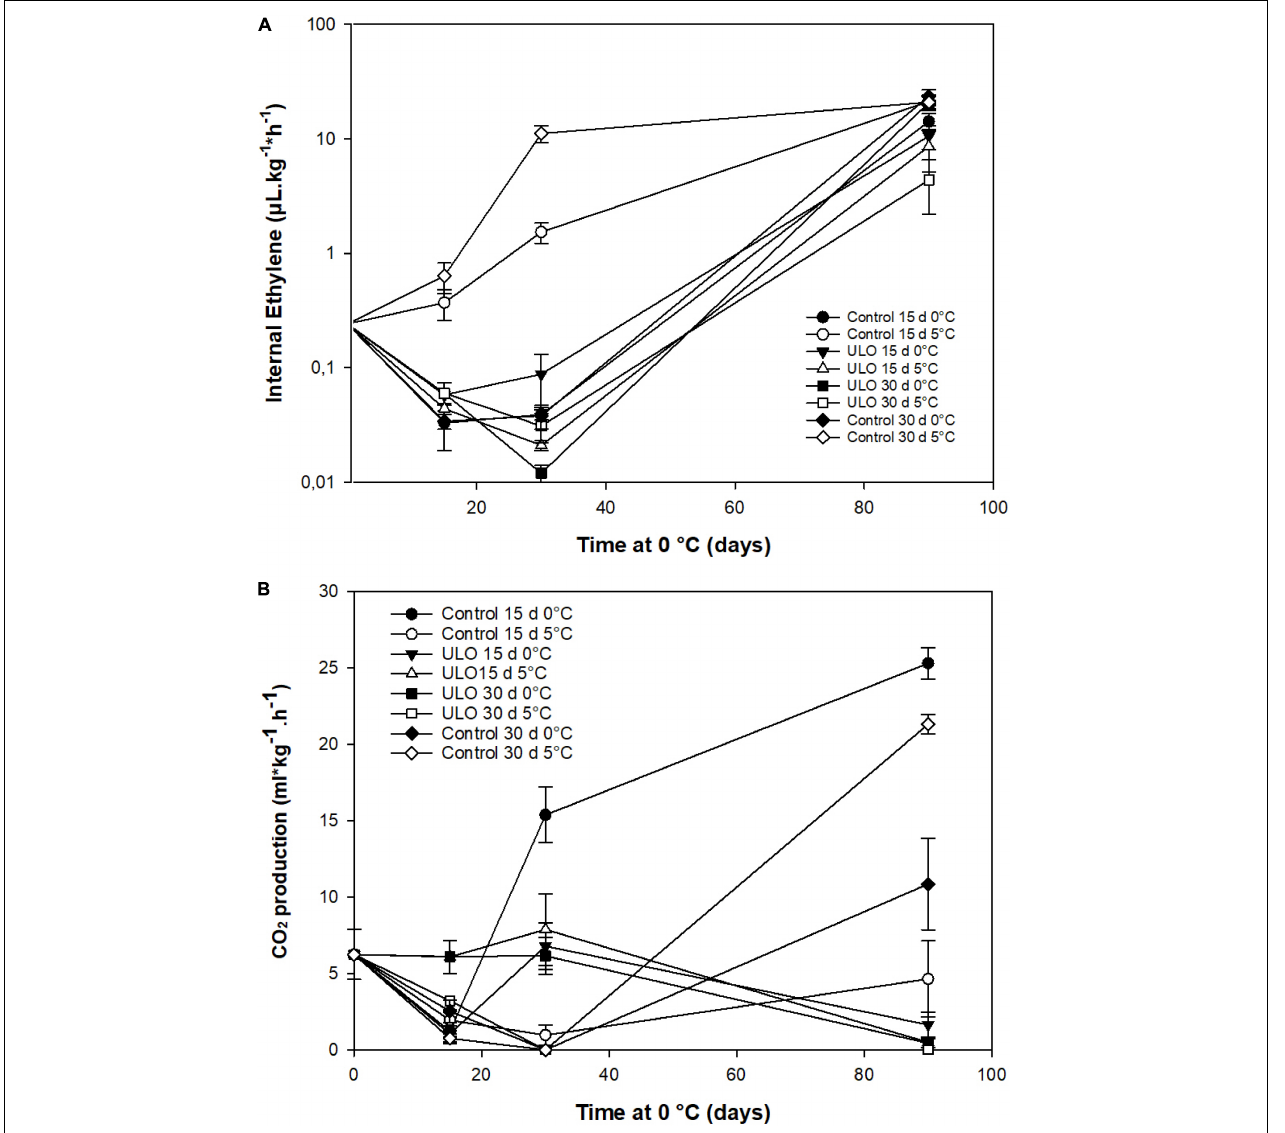
FIGURE 2 | Effect of ultra-low oxygen (ULO) conditioning treatments for 15 and 30 days at 0 or 5 ◦ C on internal ethylene production (A) and respiratory rate (B) of ‘Fuji’ apples stored for 90 days at 0 ◦ C, plus 9 days of ripening at 20 ◦ C. Values are means ± standard error, n = 4 replicates. ULO, ultra-low oxygen conditioning treatment; Control, conditioning temperature treatment under air